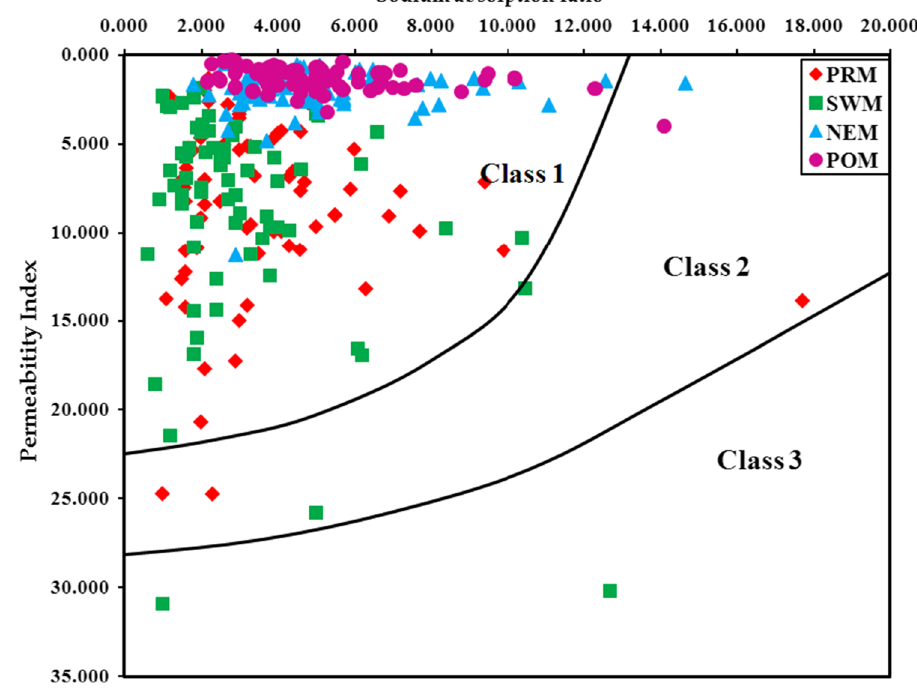
Fig. 6 Modified Doneen’s plot for determining the appropriate- ness of groundwater for differ-